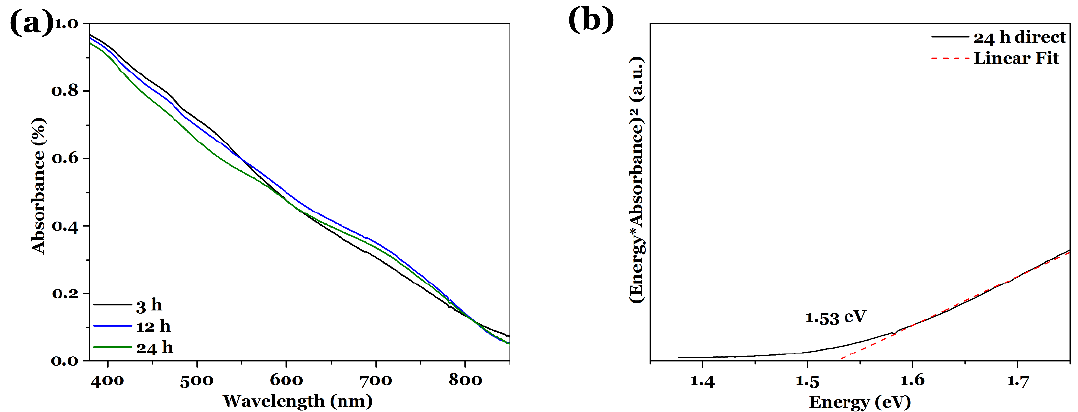
Figure 3. ( a ) UV-vis spectra of CuInS 2 thin films on FTO substrate, synthesized solvothermally with L -cysteine for 3, 12 and 24 h at 150 °C. ( b ) Exemplary Tauc plot for direct semiconductors for film_24 h, indicating a band gap of 1.53 eV.